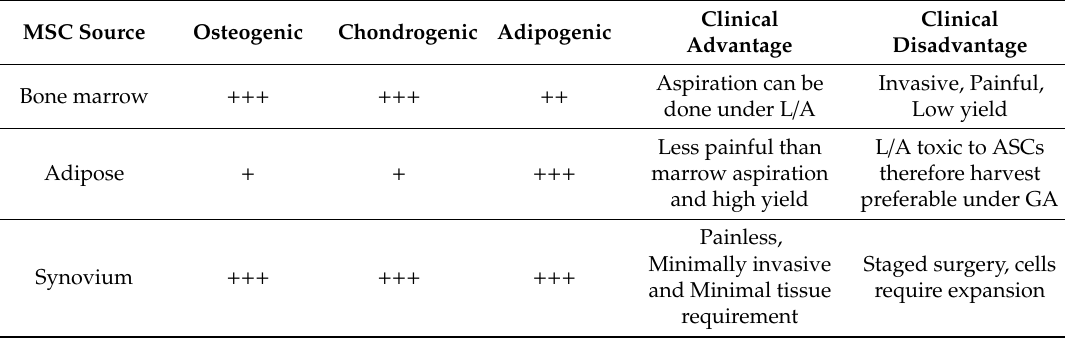
Table 1. Summary table showing di ff erentiation capacities as well as advantages and disadvantages of bone marrow, adipose and synovium mesenchymal stem cells (MSCs) [64,66–71]. MSC Source Osteogenic Chondrogenic Adipogenic